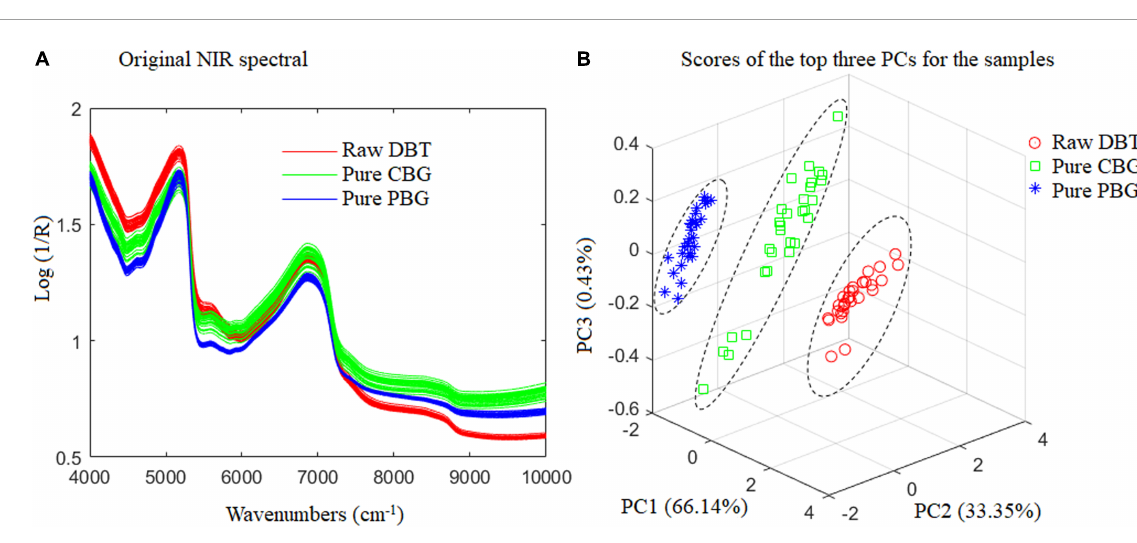
FIGURE5 The raw NIR spectral and scatter diagram of the top three principal component analysis scores of the raw duck blood tofu (DBT), pure cow blood-based gel (CBG), and pig blood-based gel